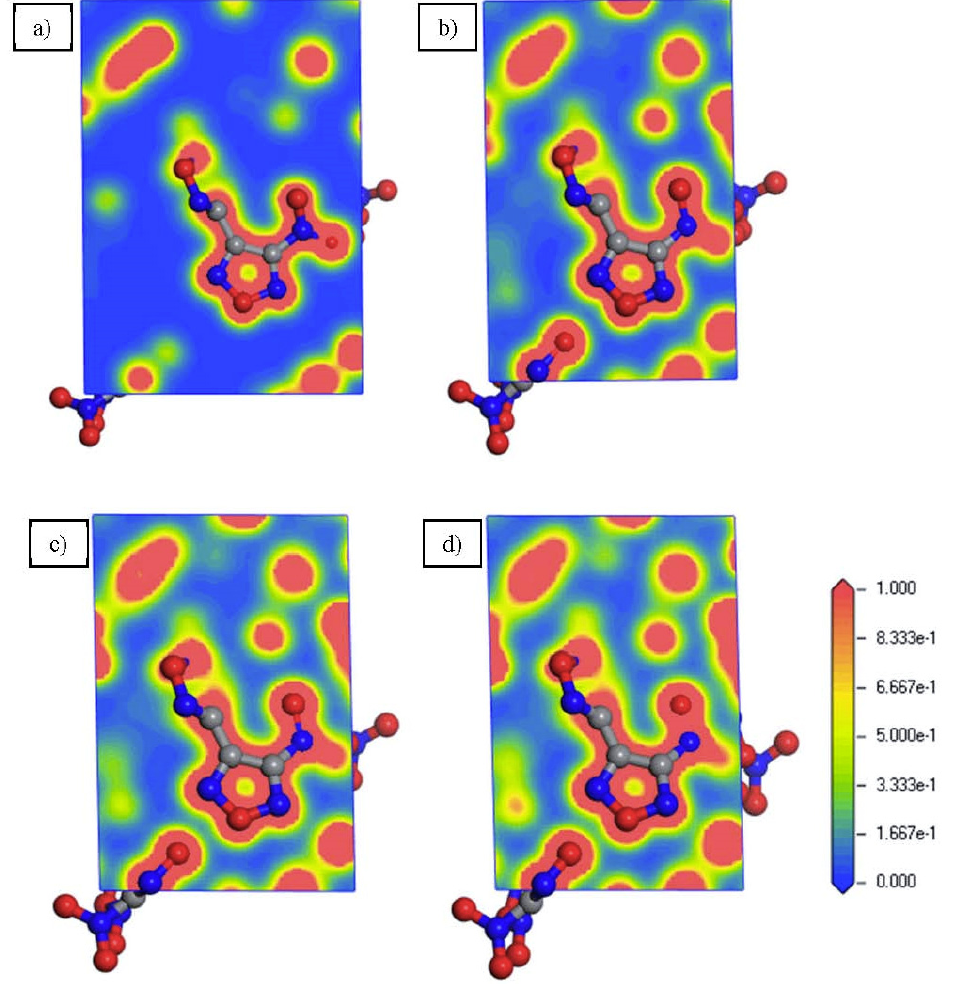
Figure 8. The electron density of DNTF under different pressure. ( a ) 0 GPa; ( b ) 20 GPa; ( c ) 40 GPa; ( d ) 60 GPa.